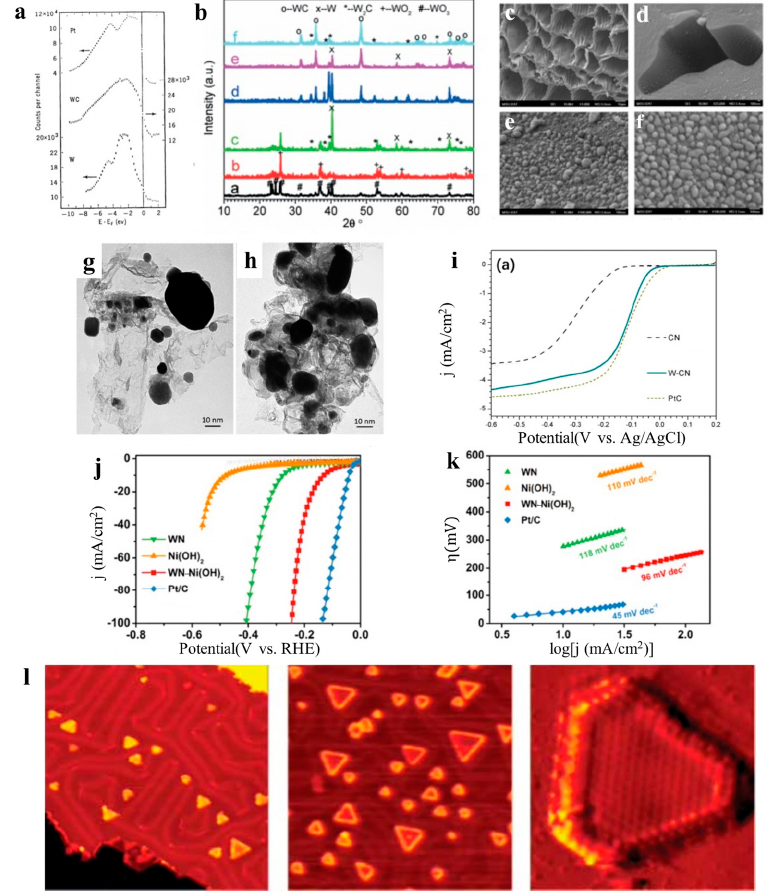
Figure 7. ( a ) Valence band XPS spectra of Pt, WC and W (111). ( b ) The XRD patterns of tungsten ‐ promoted biochar samples prepared by carbothermal reduction for 1 h at different temperatures. Tungsten promoted the SEM image of biochar after carbothermal reduction at 1000 °C for 1 h ( c – e ) and carbothermal reduction at 1000 °C for 3 h ( f ). TEM images of tungsten ‐ promoted biochar after carbothermal reduction for 1 h ( g ) and 3 h ( h ) at 1000 °C. ( i ) ORR polarization curves for CN, W ‐ CN and PtC in 0.1 M KOH with a scan rate of 5 mV/s and a rotating rate of 1600 rpm. ( j ) LSV curves and ( k ) Tafel plots of WN ‐ Ni(OH) 2 , WN, Ni(OH) 2 and Pt/C. ( l ) Atomic structure of a nanotriangular transition metal sulfide in the monolayer.